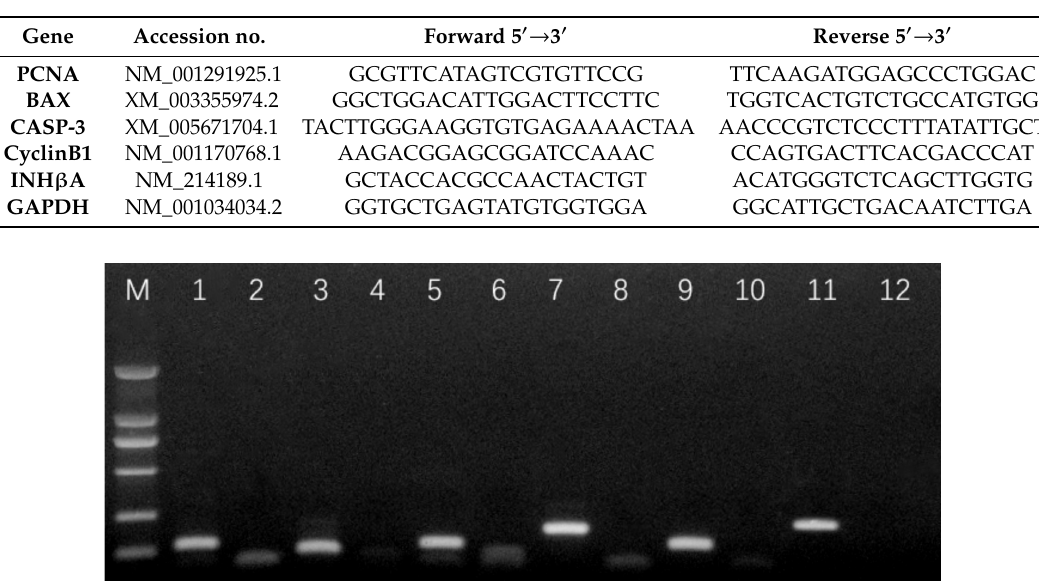
Table 1. List of primers used for qRT-PCR.